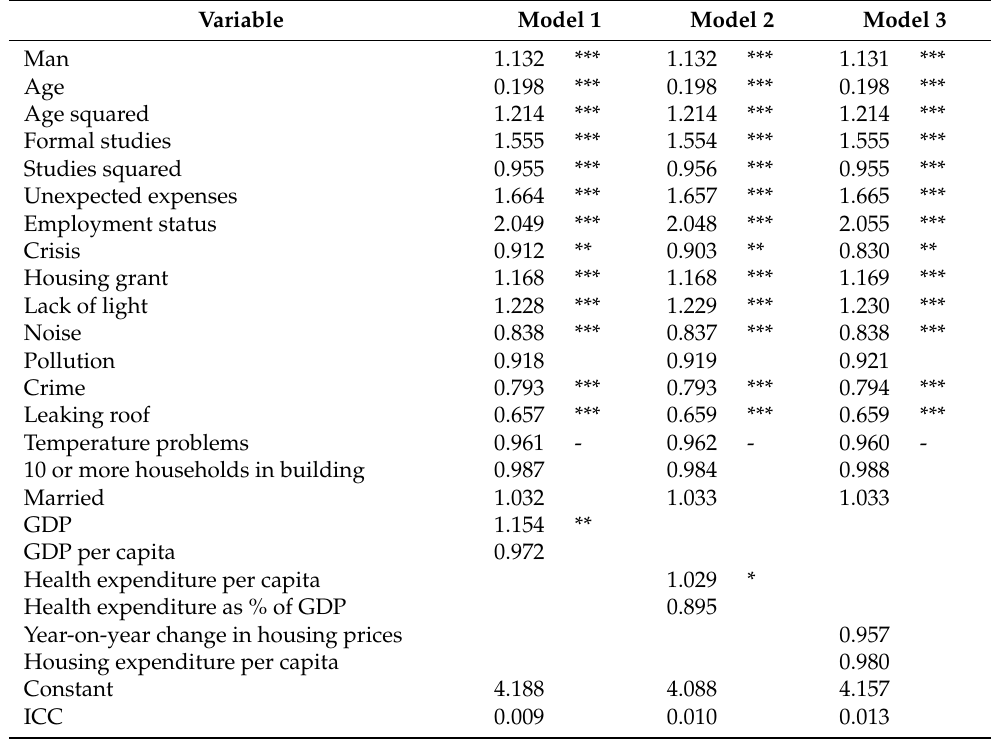
Table 4. Multilevel logistic regression models for the subjective health